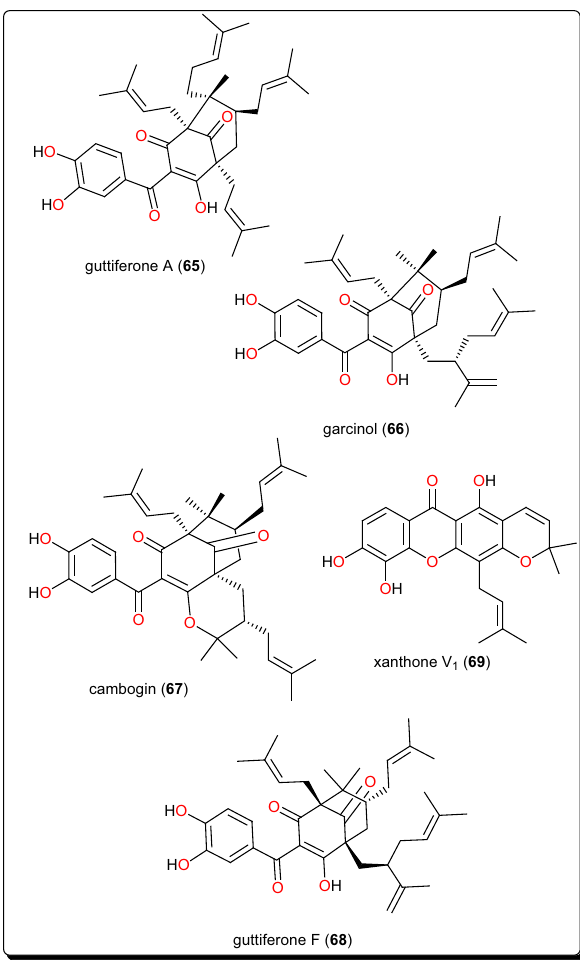
Fig. 12 Acylphloroglucinols and a xanthone with very potent in vitro antileishmanial activities in the nanomolar range